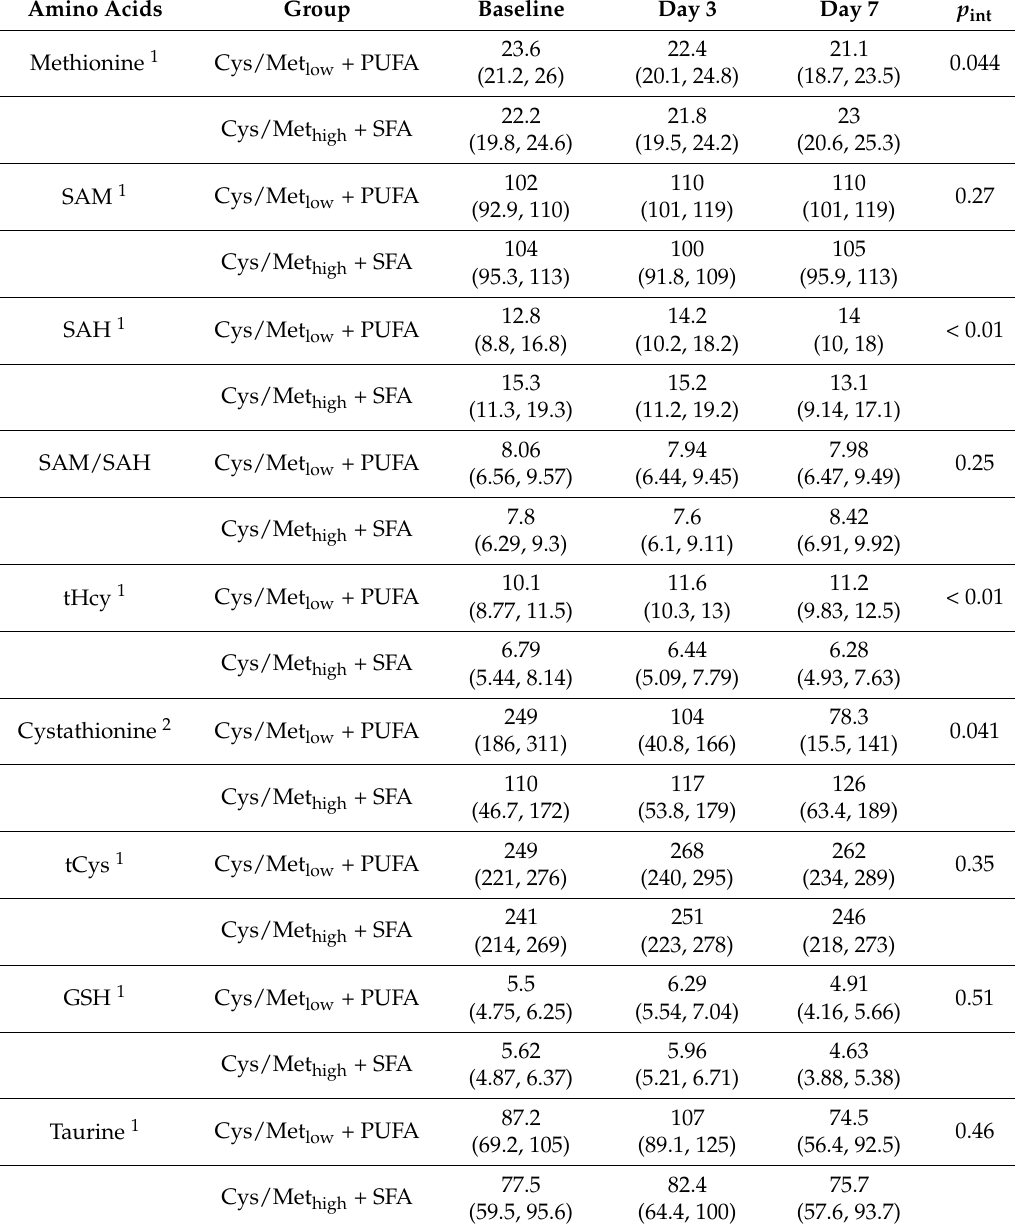
Table 2. Estimated marginal means (95% confidence interval) of plasma concentrations of amino acids and related